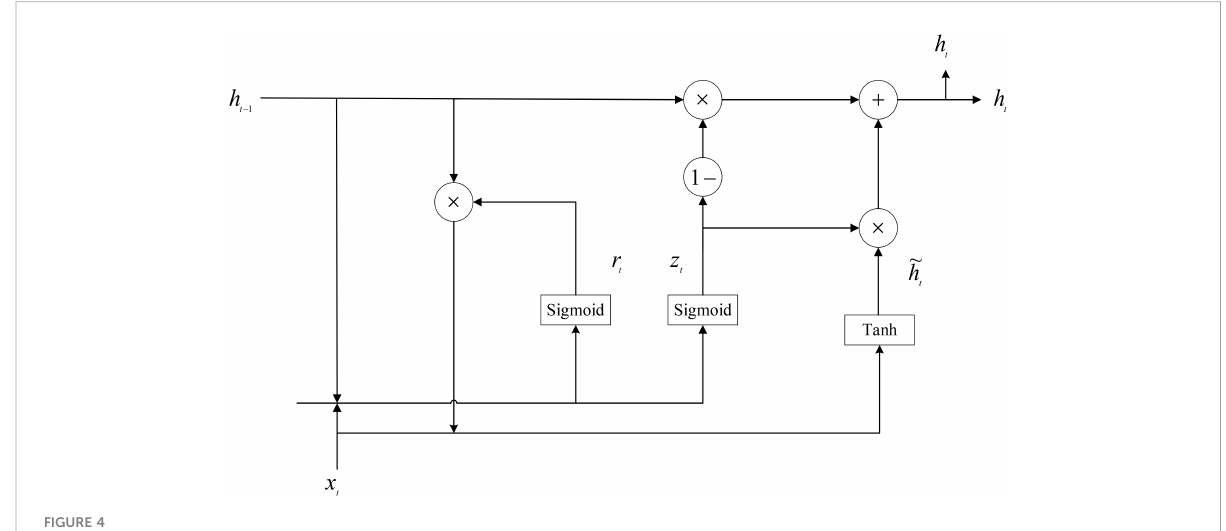
FIGURE 4 GRU module